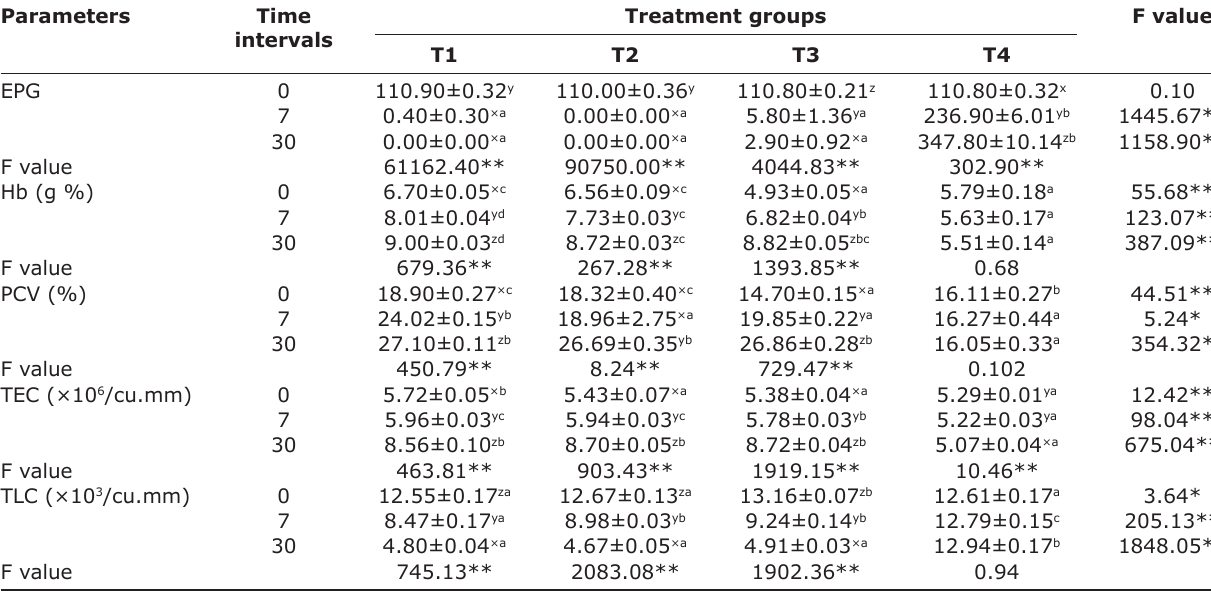
Table-2: Hematological changes in various treatment groups at different time intervals in fasciolosis of goats. Parameters Time Treatment intervals